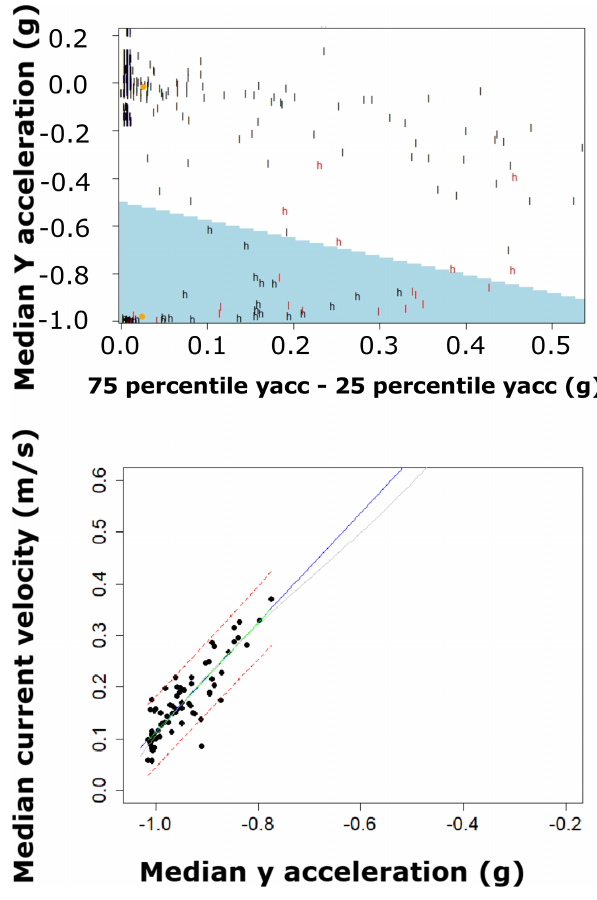
Figure A2. Calibration of 10s measurement interval data for 15min time steps. (a) Linear discriminant analysis for North Sumatra dataset (B11 and B12) using 10s interval acceleration data and aggregation over 15min time steps (l is low tide, h is high tide, and red letters are false predictions). Additionally, the LDA group averages are indicated as orange dots. The − 0 . 5 y acceleration threshold to separate inun- dation from non-inundation time steps was applied for the R shiny application. Linear regression (blue line) provided the best fit for the me- dian y -axis acceleration [ Y acc (g)] against the measured current velocity of B1 [ V cur (ms − 1 )] for 15min intervals: V cur = 1 . 173 + 1 . 059 · Y acc , R adj = 0 . 7724, P < 0 . 05. The grey line shows the 1Hz deployment regression line of Fig. 3 and the green line the predictions within the measured range of values.